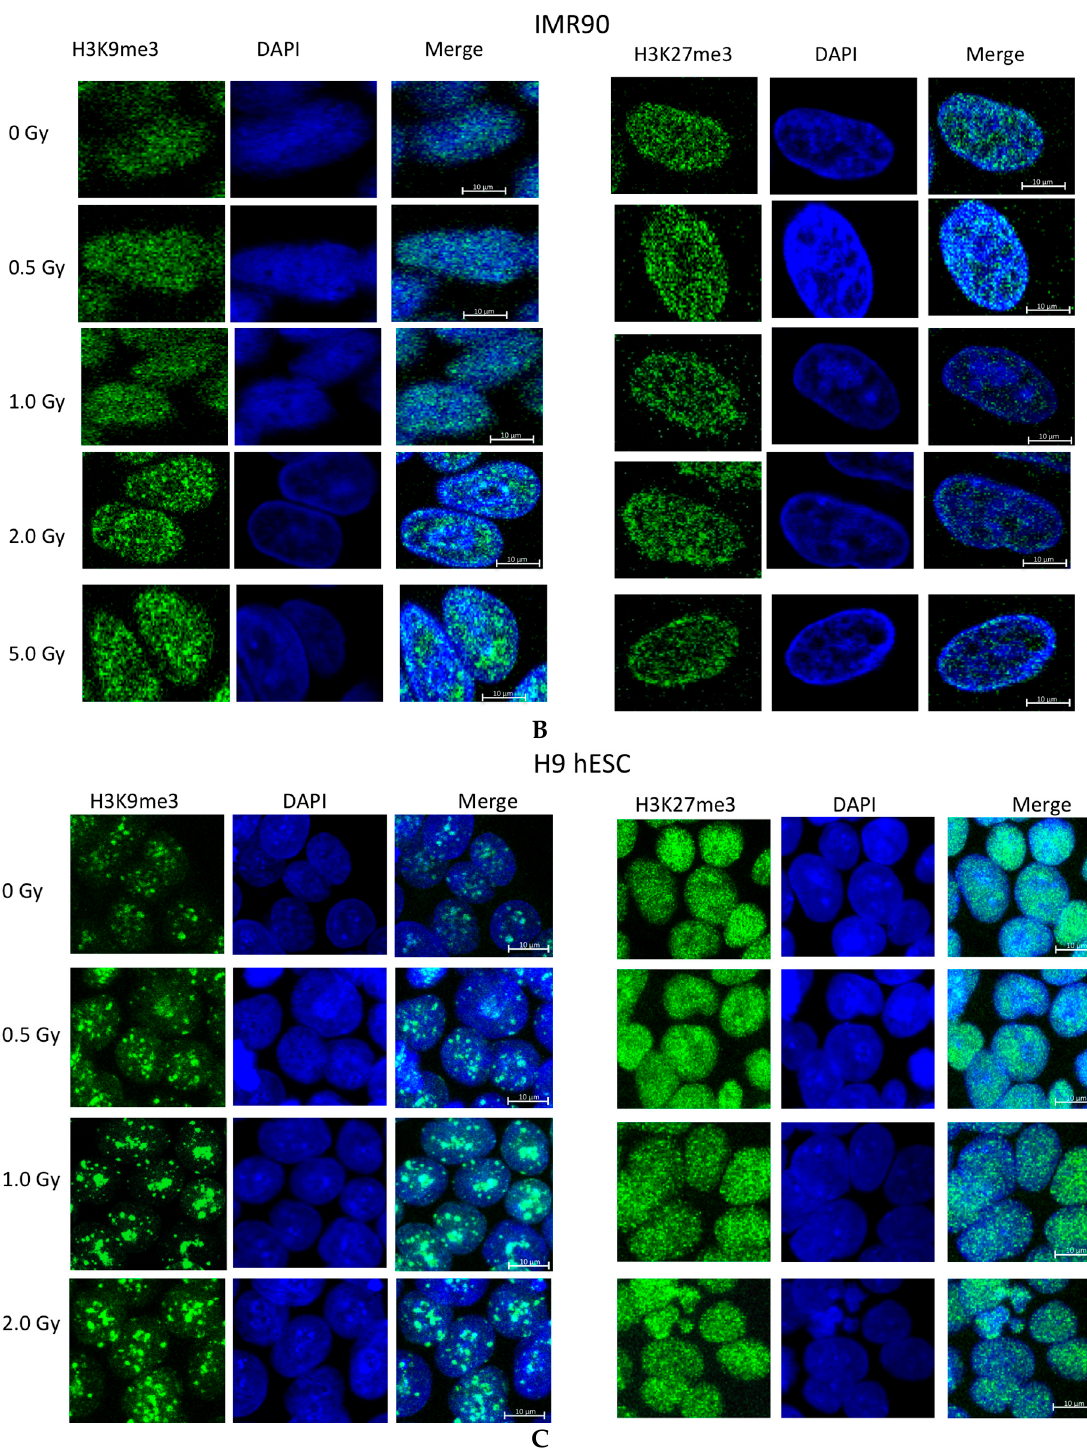
Figure 2. Cont. Figure 2.